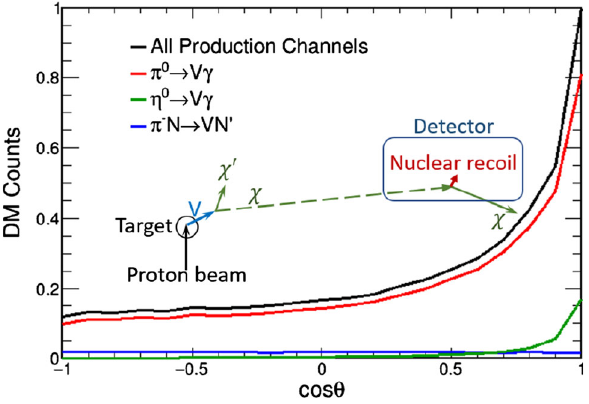
Fig. 14 Angular distributions of DM particles created from various channels. The inlet shows the production and detection mechanism